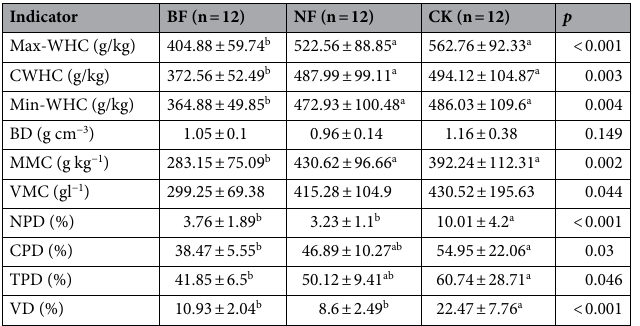
Table 1. ANOVA of the soil physical properties of different slash disposal methods in GSDFF. The data form as: average value ± standard deviation standard of significant difference. The relationships of superscript letters a, b and c are that a is significantly higher than b and c, and b is significantly higher than c.